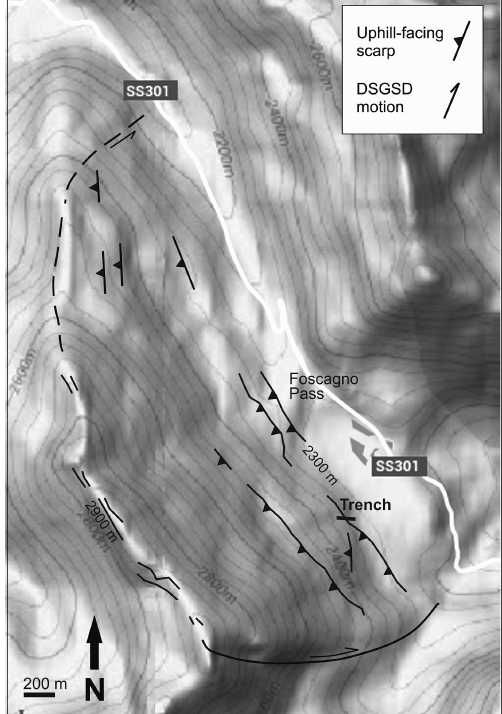
Figure 4. Digital elevation model of the area of the DSGSD near the Foscagno Pass (central Alps, Italy), with location of the trench studied by palaeoseismological techniques, and trace of the main Holocene morphostructures of the